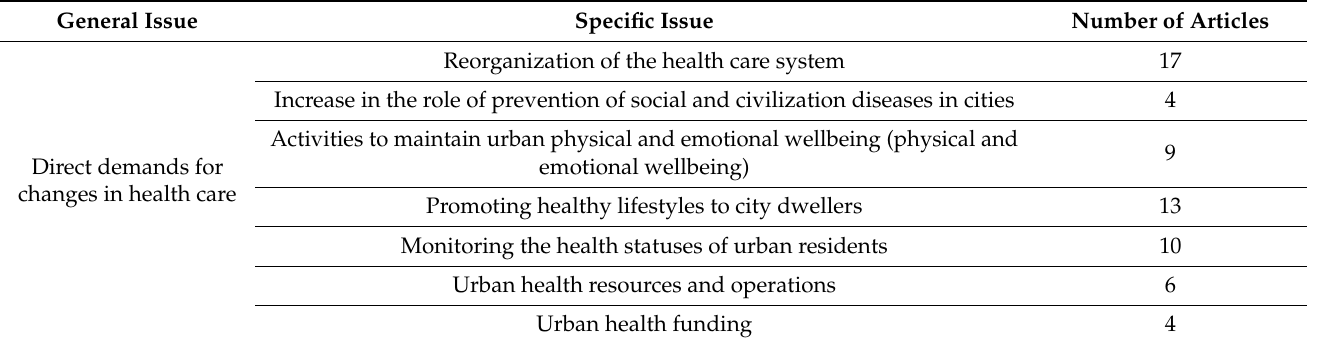
Table 2. Publications related to thematic